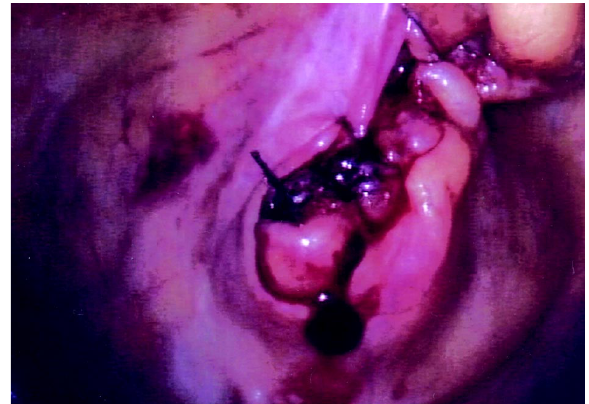
Figure 6 – Final aspect of cystotomy